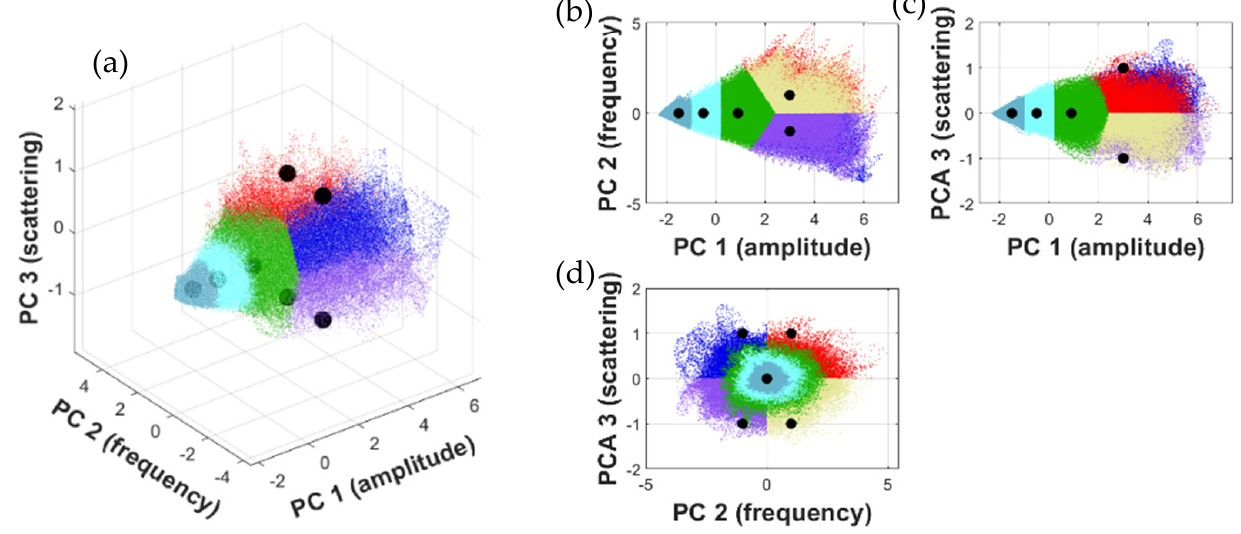
Figure 8. ( a ) Typical 3D feature space representation (3D scatterplot), where each colored data point represents a spatial pixel in the original radargram. The 2D scatterplots on the right show the same information but as ( b ) horizontal, ( c ) vertical, and ( d ) lateral projections.